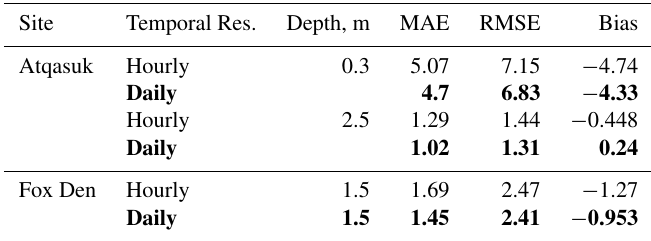
Table F1. Atqasuk modeled water temperature errors calculated from measured water temperature time series at 0.3 and 2.5m across different temporal resolution simulations. Bold rows are the lowest RMSE for a given water depth. The following variables are included: mean absolute error (MAE), root-mean-square error (RMSE), and mean average error